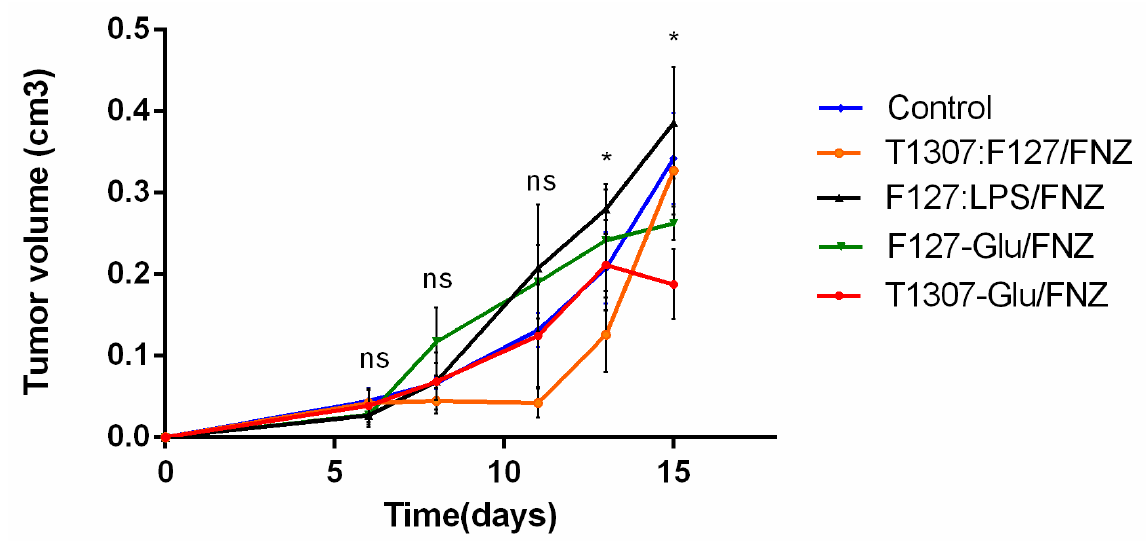
Figure 4. Evolution of tumor size during the different treatments. Data are expressed as mean ± standard deviation ( n = 6). Statically was analyzed by ANOVA “two way” followed by Tukey test. * Statistically significant reduction in tumor volume of T1307:F127/FNZ treatment respect to control at day 14 and of F127-Glu/FNZ or T1307-Glu/FNZ treatments respect to control at day 16.